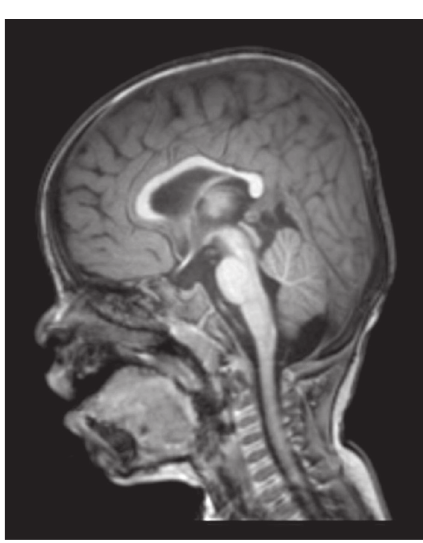
Figure 3: Brain MRI showing normal and progressive myelination but mild loss of volume in the corpus callosum.